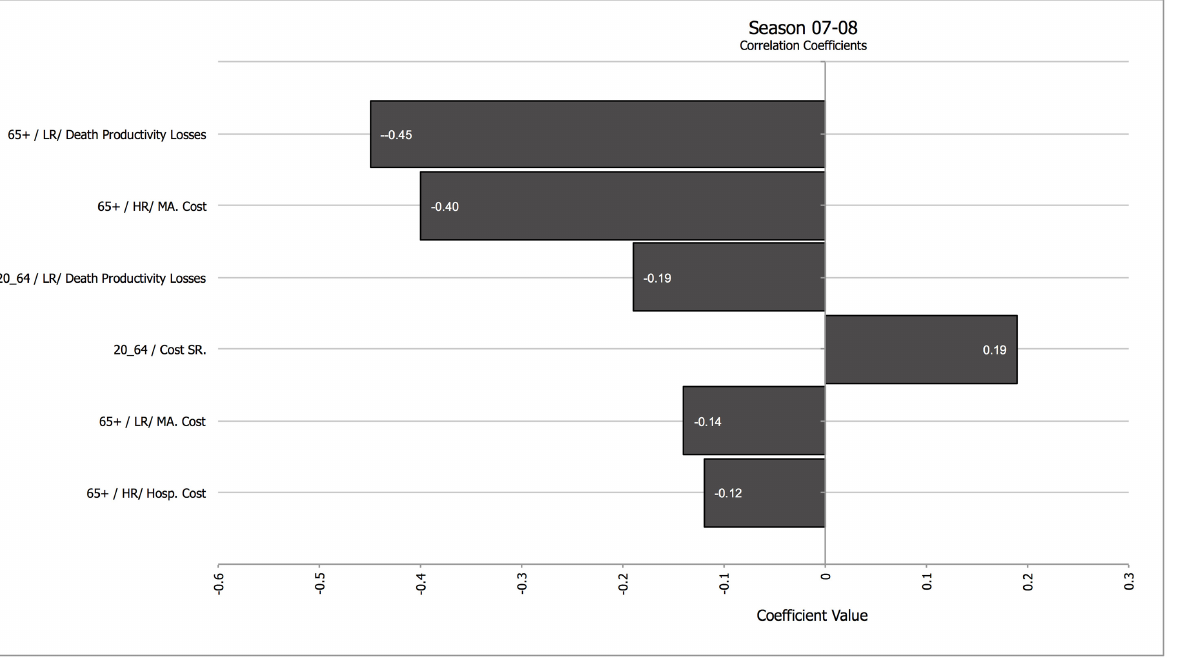
Fig 3. Tornado coefficient for Net Costs (all age cohorts, including productivity losses, societal perspective) for season 07 – 08. Correlation coefficients in the horizontal axis. Abbreviations: Cost SR. – Cost of Systemic Reaction; HR — High Risk; LR: Low Risk; MA — Medically Attended. When applicable, the numbers in the left of the factor represent the age cohort the costs refer to. Components with correlation values < 0.1 were not